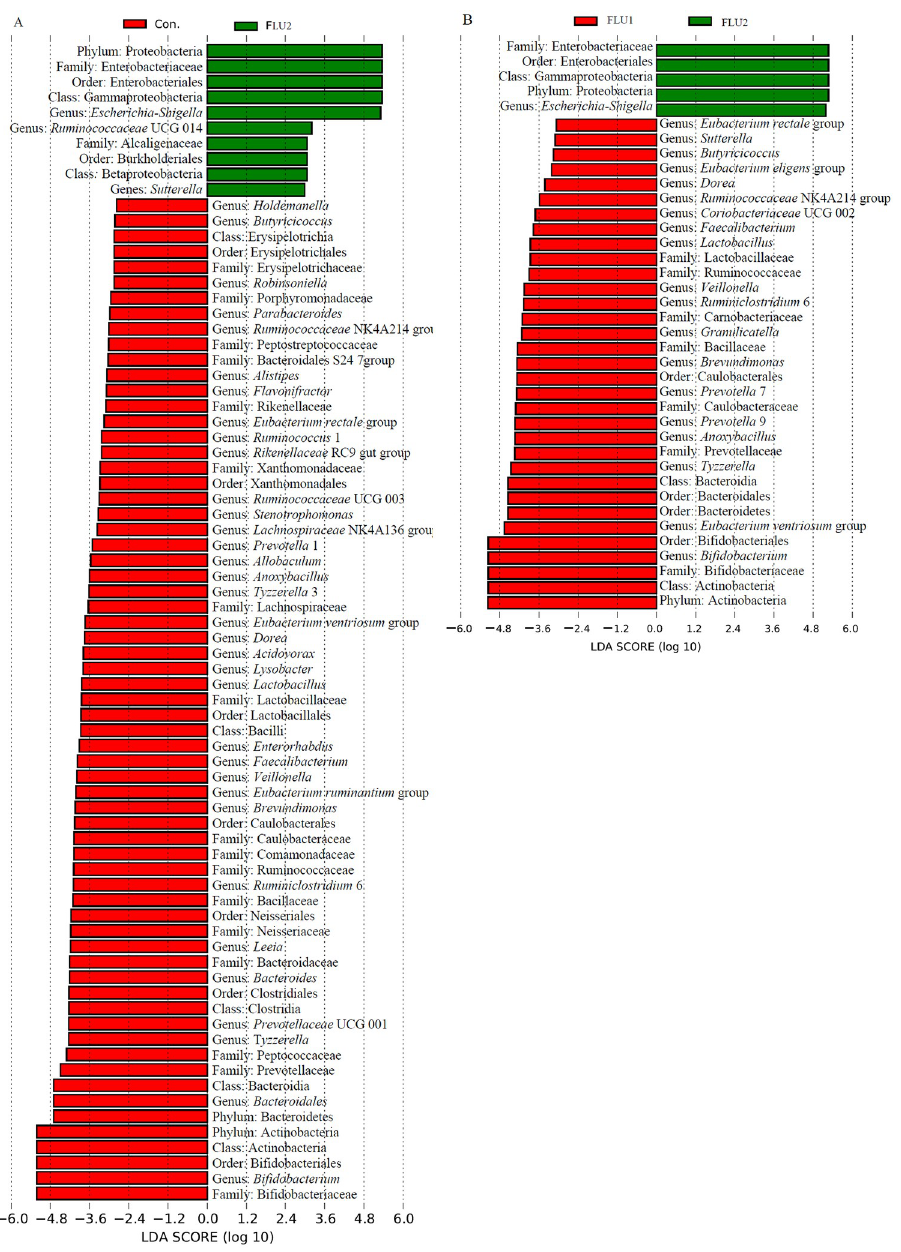
Fig 2. Analysis of the different abundant bacterial taxa using LEfSe. The bacterial percentage of the fermented samples was used for LEfSe analysis. The P-value < 0.05 was identified as being significantly different between groups. Significantly enriched bacterial phyla, classes, orders, families, and genera are listed next to the histogram. Con, FLU1, and FLU2 represent samples collected after cultured using VI media with DMSO, 20 μ M, and colon concentration of FLU. A Significantly different bacteria between FLU1 and FLU2. B Significantly different bacteria between groups of FLU2 and DMSO.